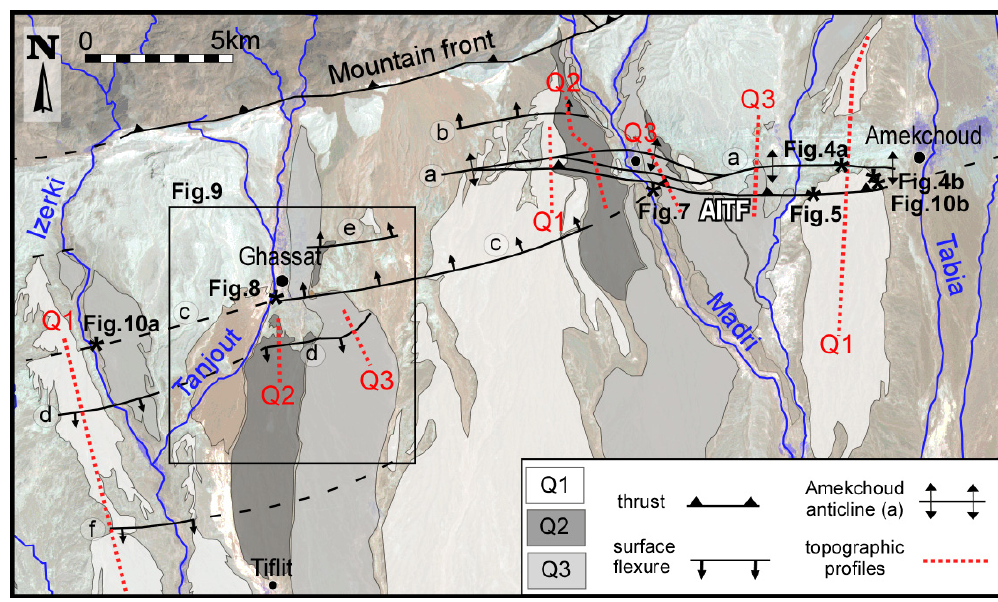
Figure 2. Detailed map of the older Quaternary deposits in the study zone, with the main Quaternary structures (as 'a' to 'e'). The topographic profiles of the Quaternary surfaces (red dashed lines) and the location of field photographs (numbered) are also indicated. AITF: Amekchoud-Imidir thrust